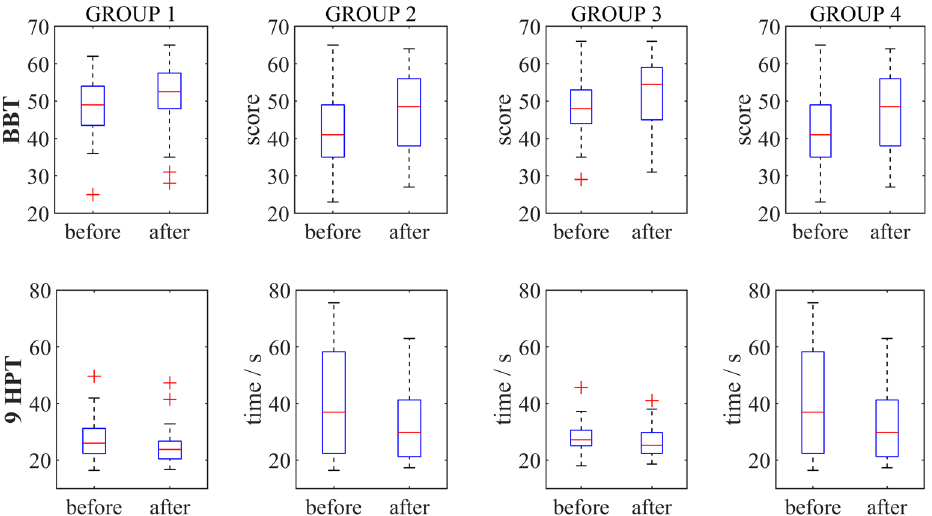
Figure 7. All participants improved their BBT and 9HPT performance (Cohen’s U3), but no statistically significant differences were found between groups (BBT: χ